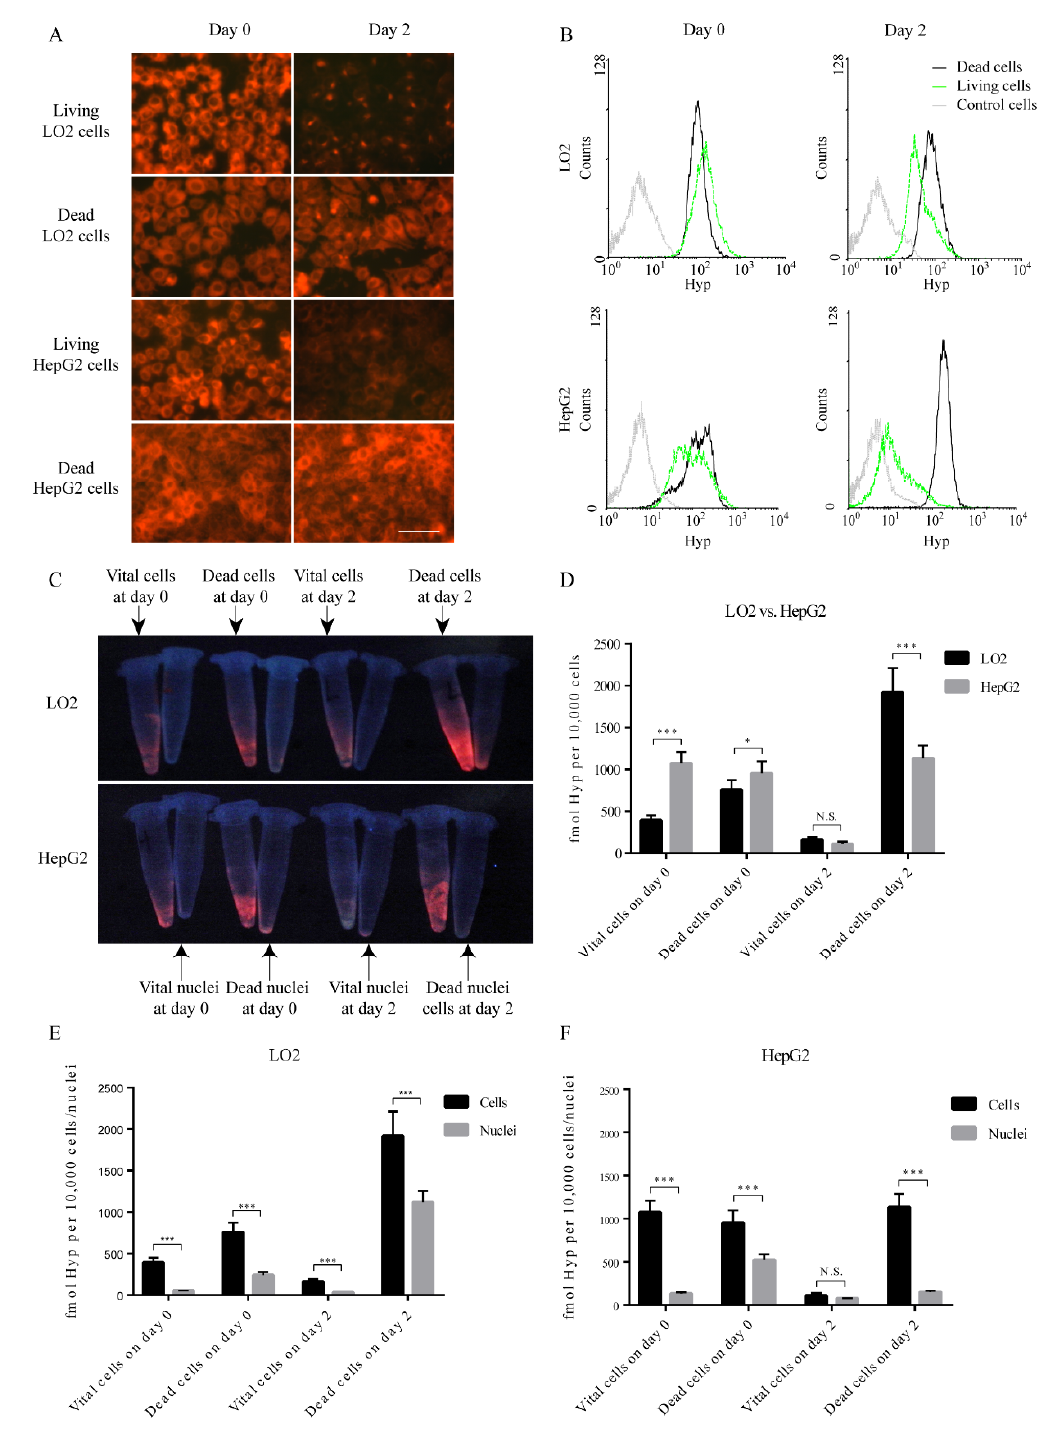
Figure 2. Hyp fluorescence in vital or dead neoplastic and nonneoplastic hepatocytes and paired nuclei. ( A ) The red fluorescence of Hyp observed by fluorescence microscopy in neoplastic and nonneoplastic cells at early and late stages. Scale bar = 50 µ m. ( B ) Flow-cytometry histograms of Hyp fluorescence in control cells, vital cells, and dead cells. The control cells were not incubated with Hyp. ( C ) The fluorescence image of Hyp in cells and nuclei. ( D ) Comparison of Hyp concentration by RP-HPLC between LO2 and HepG2 cells (N = 3, Student’s t test). ( E ) Comparison of Hyp concentration measured by RP-HPLC on either cells or nuclei in LO2 cells (N = 3, Student’s t test). ( F ) Comparison of Hyp concentration measured by RP-HPLC on either cells or nuclei in HepG2 cells (N = 3, Student’s t test).